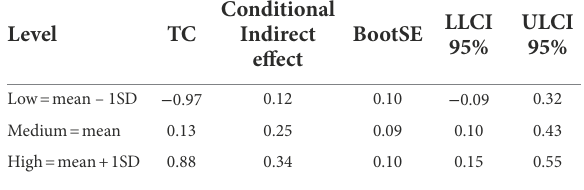
TABLE 4 Conditional indirect effect testing for Hypothesis